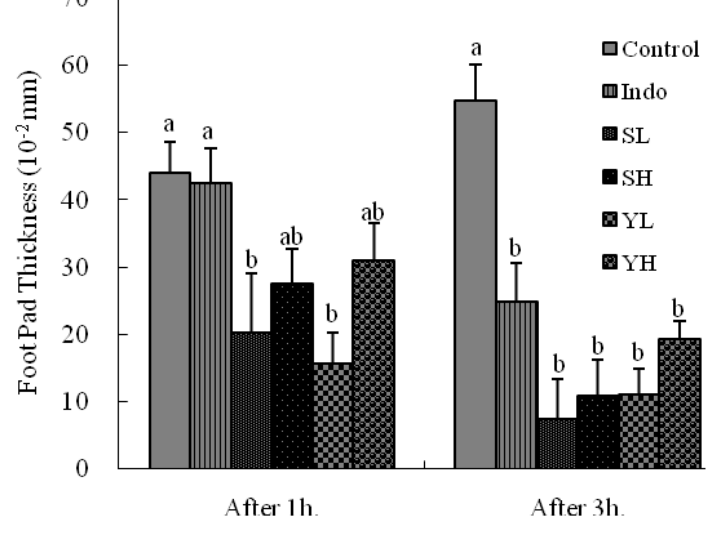
Figure 2. Effects of SoRiTae and Yak-Kong ethanolic seed extracts on carrageenan- induced paw edema. Indo: Indomethacin (10 mg/kg); SL: SoRiTae (100 mg/kg); SH: SoRiTae (200 mg/kg), YL: Yak-Kong (100 mg/kg), YH: Yak-Kong (200 mg/kg). Each values was expressed as the mean ±S.E.M. (n = 6). a-b Means in the same column not sharing a common letter are significantly different (p < 0.05) by Duncan's multiple test.